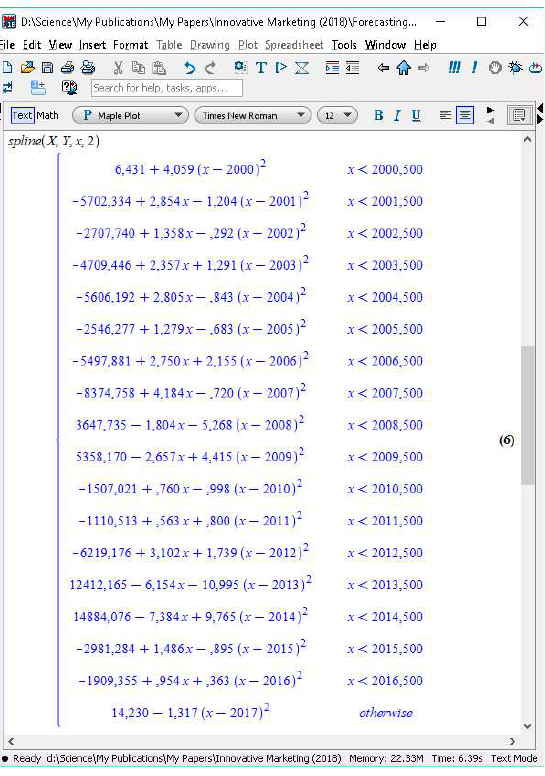
Figure A4. Function description of cubic